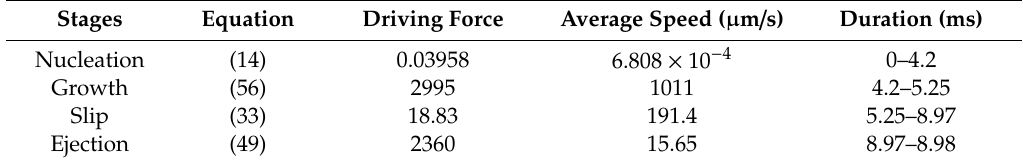
Table 1. Thedrivingforces, averagespeed,